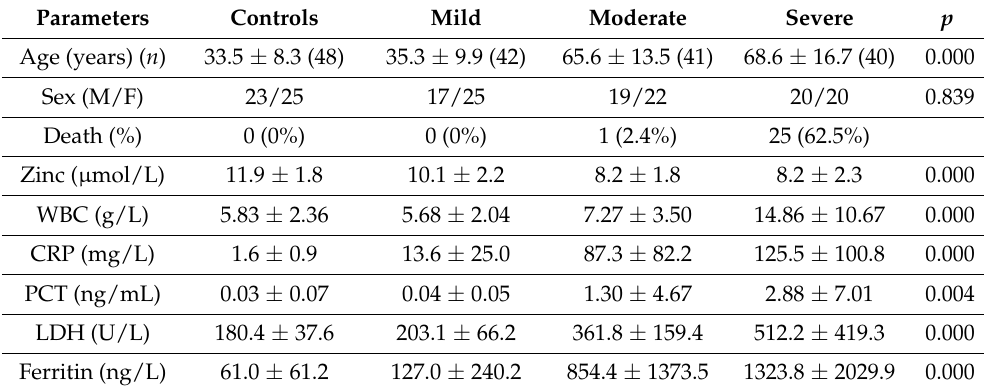
Table 2. Demographic and laboratory parameters of control group and COVID-19 groups according to the severity of infection.